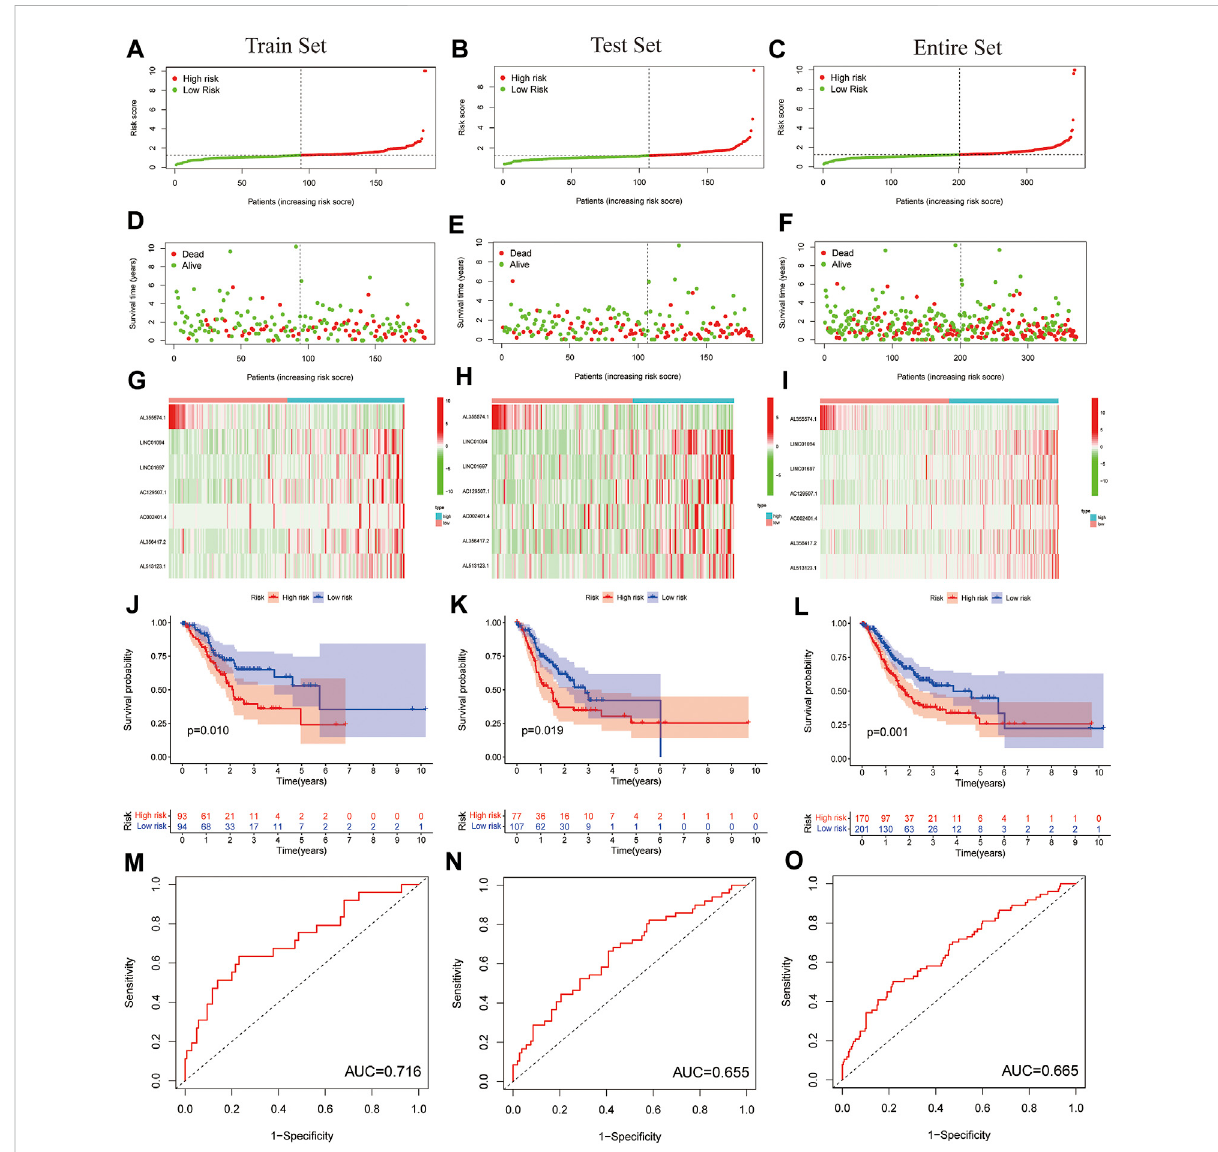
FIGURE 3 Prognostic value of the risk model of the seven PLT-related lncRNAs in the testing set and training set. (A – C) Distribution of PLT-related lncRNAs model presented based on a training set, testing set, and entire set risk scores. (D – F) Survival time and survival status of low- and high-risk groupsforthetrainingset,testingsetandentireset. (G – I) Heat-mapsofsevenLncRNAexpressionsinthetrainingset,testingset,andentireset. (J – L) Kaplan-Meier survival curves of the OS of patients in thetraining set, testing set, and entire set. (M – O) ROC curve of the training set, testing set, and entire